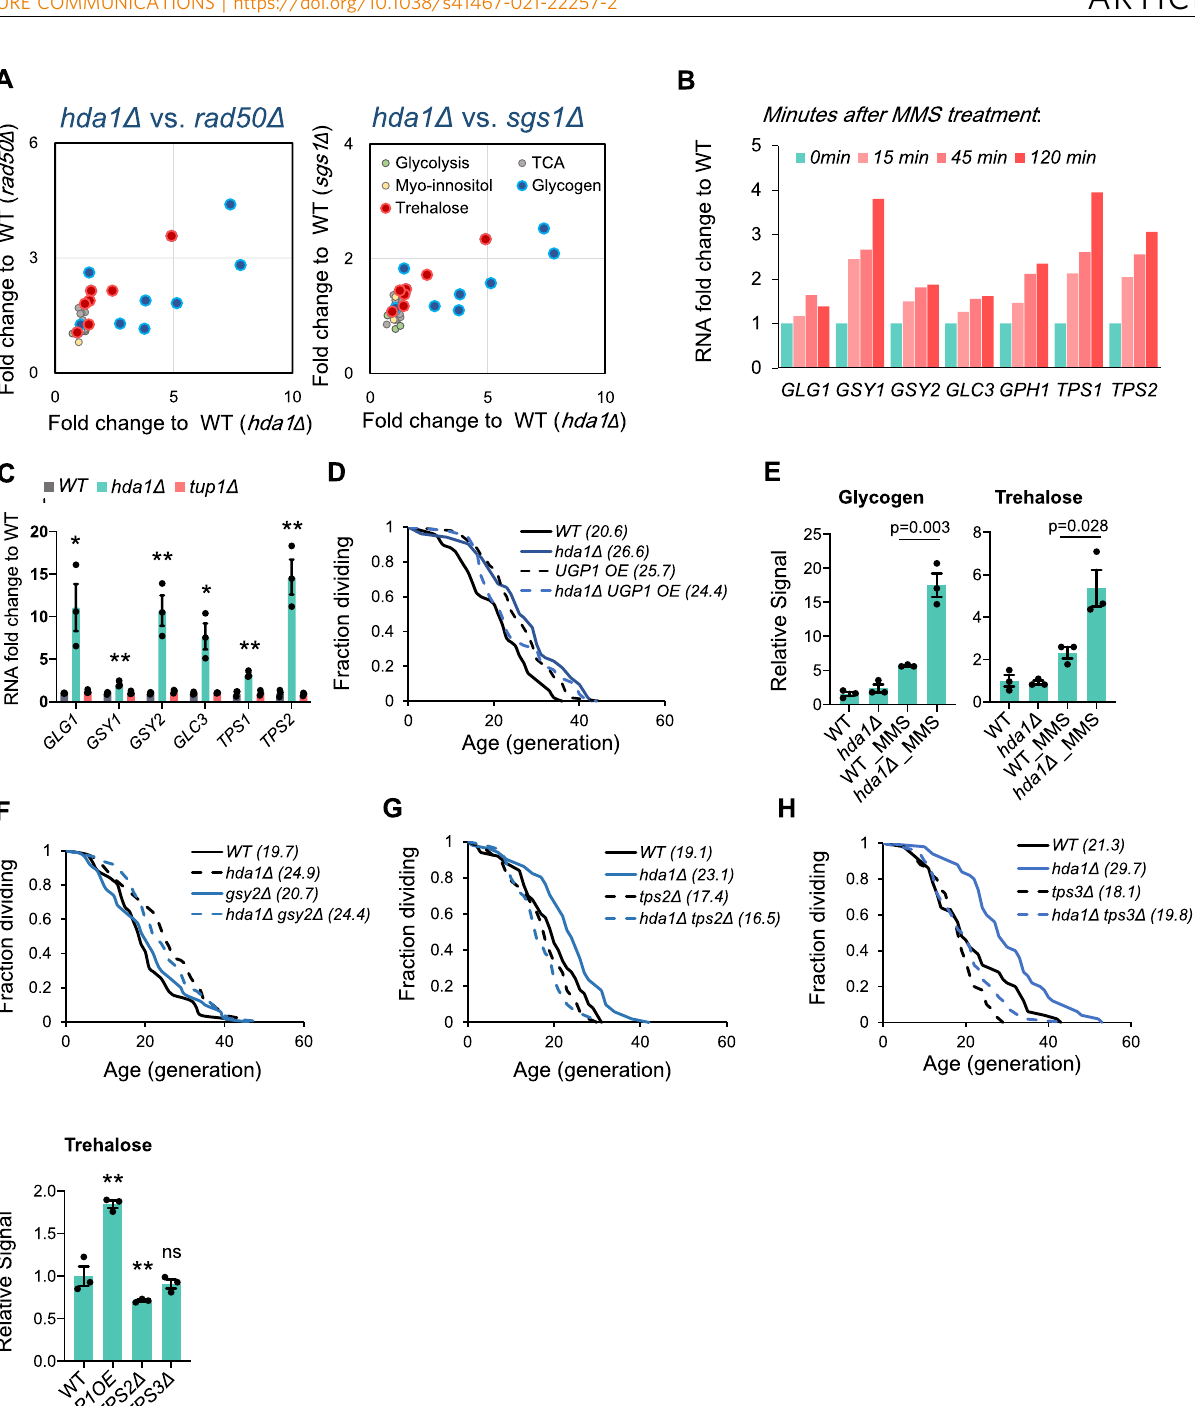
detect H3K18 acetylation, we con fi rmed an increase in promoter acetylation at trehalose metabolism genes (Fig. 7G). These changes were not visible on genes not activated by HDA1 deletion, such as glycolysis pathway genes, suggesting that HDA